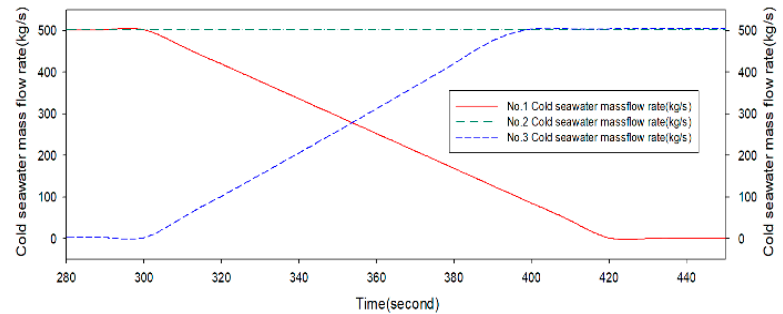
Figure 12. Flow rate gradient of deep seawater pump.